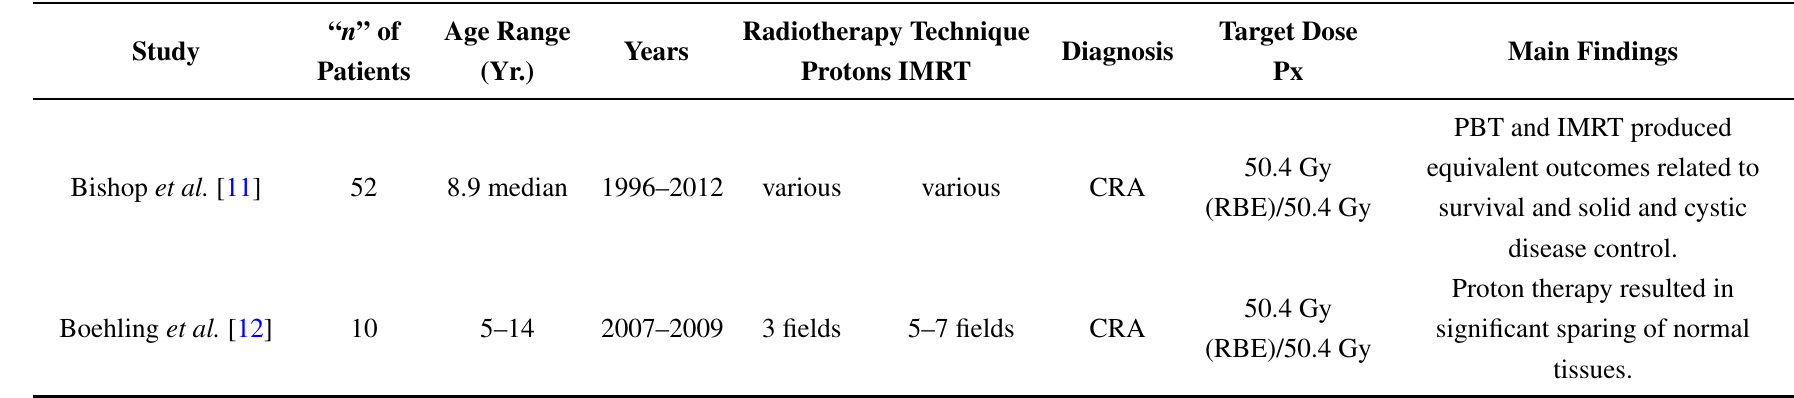
Table 2. Description of Proton versus IMRT dosimetric re-planning comparisons on paediatric CNS patients. [ Key: